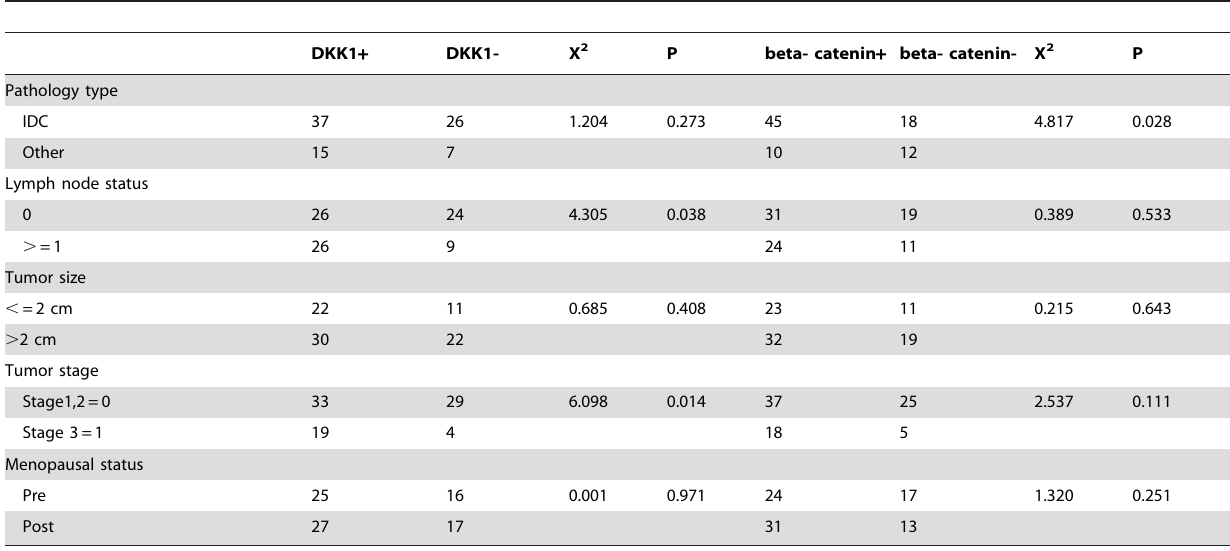
Table 6. Correlation of DKK1 and beta-catenin expression with other clinical and pathological